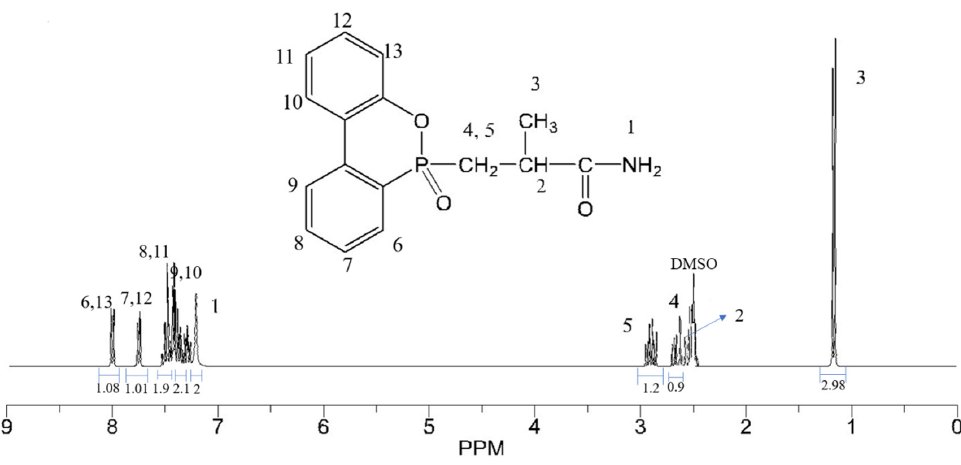
Figure 3. 1 H-NMR of DOPO-MAC.